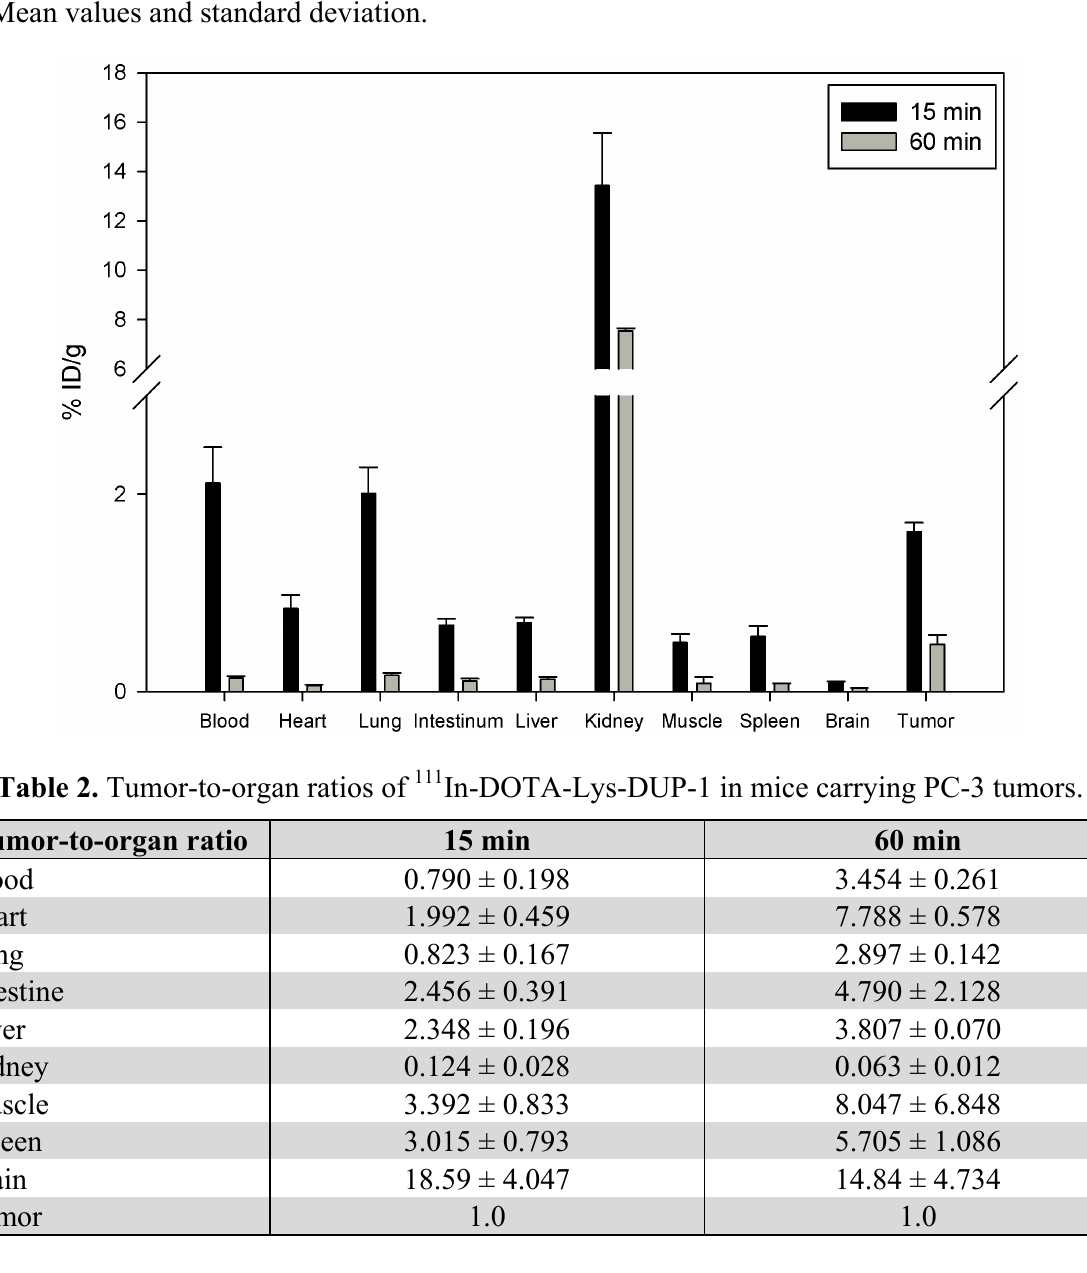
Figure 3. Organ distribution of 111 In-DOTA-Lys-DUP-1 in Balb/c nu/nu mice carrying PC-3 tumors. Activity concentration (% ID/g) in tumor and control organs is measured after 15 min (n = 3 animals) and 60 min (n = 2 animals) radioligand circulation in the mice. Mean values and standard deviation.